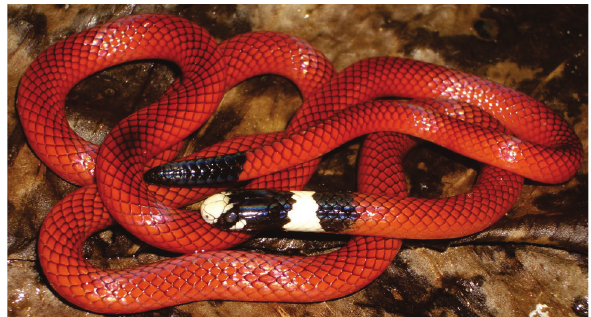
Strüssmann).Figure 9. Apostolepis assimilis . A specimen deposited at the Universidade Federal de Mato Grosso (UFMT-R 11088) from district of São Vicente, Santo Antonio do Leverger, Mato Grosso, Brazil (photo by Christine